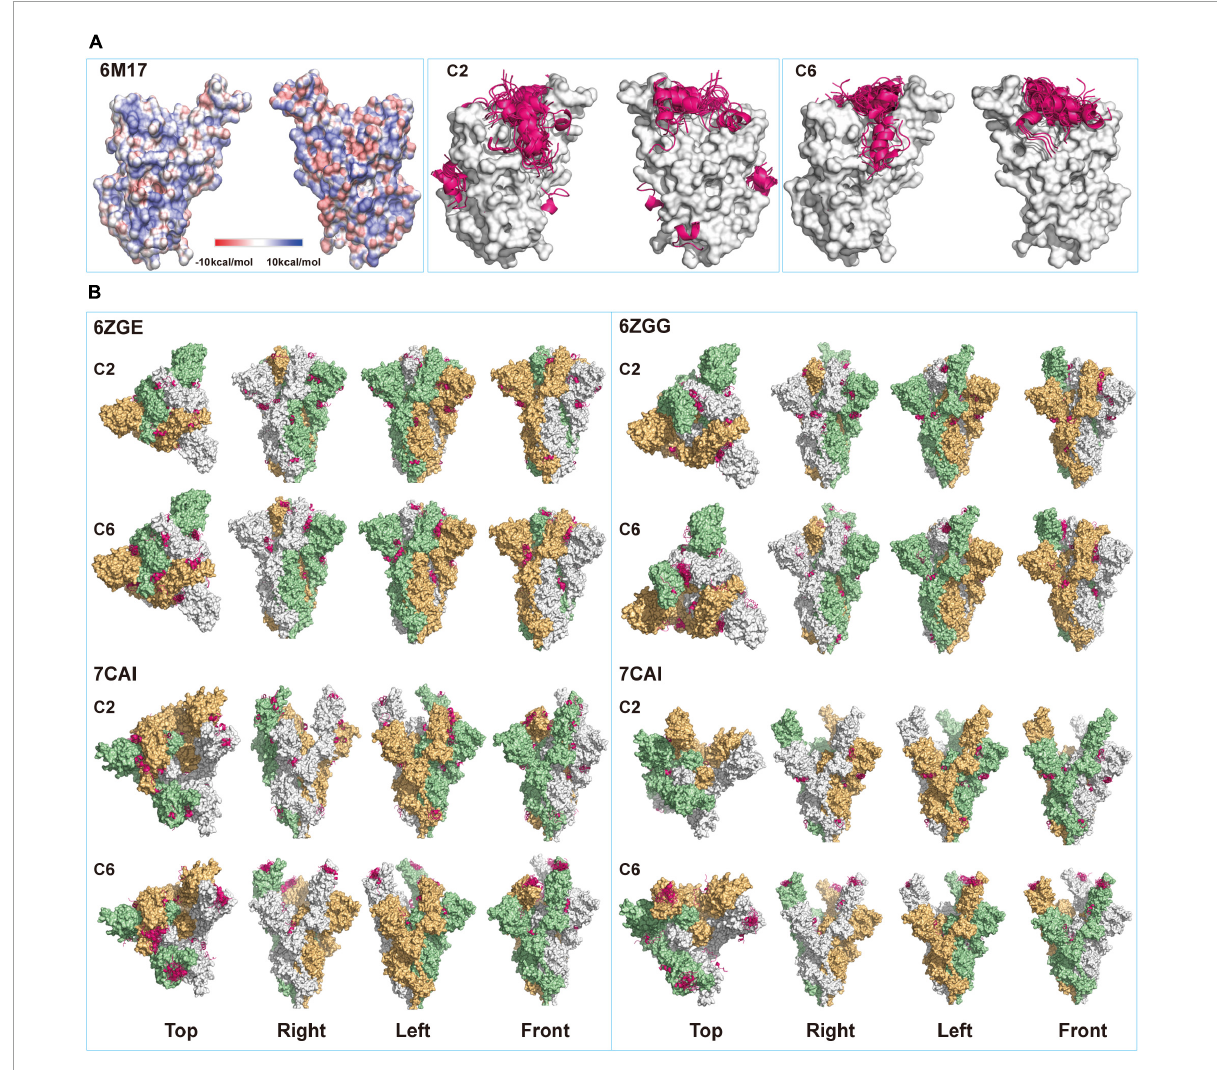
FIGURE2 Structural modeling of peptides-spike interactions. (A) Comparing binding patterns for C2 and C6 peptides (pink belts) onto spike-receptor-binding domain (S-RBD). Shown are the fifty poses with the highest of each binding exclusively onto the saddle of RBD (6M17, open), some poses of C2 peptide bind onto other sites on the surface of RBD. (B) Four configurations corresponding to the different status of RBDs in the S-trimers (6ZGE, 6ZGG, 7CAI, and 7CAK for 0, 1, 2, and 3 RBDs open, respectively) were compared for their potential bindings with the two peptides. Each figuration was given a view from the top, right, left, and front